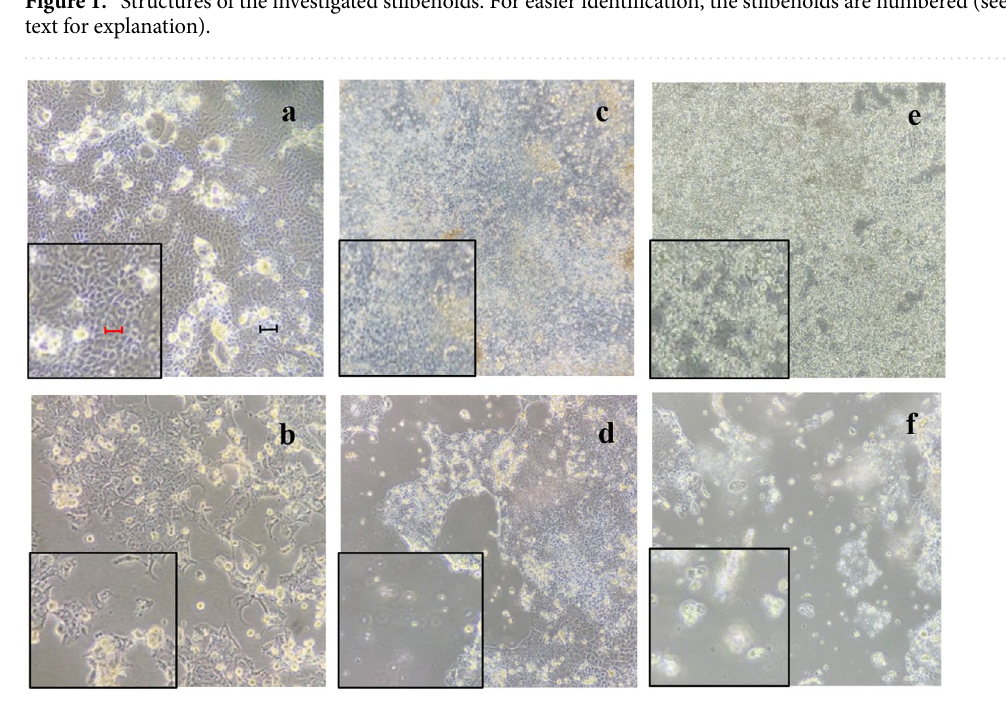
Figure 2. Microscopic observations of differentiated Caco-2 cell morphology after treatment with: ( a ) DMSO vehicle only, the cells are all well adherent to the substrate and appear whit a physiological morphology; ( b ) 5-AzaC positive control, is evident an inhomogeneous cellular mat and contracted cells; ( c ) VF20, some cells appear detached and rounded (evident in the difficulty of focusing); ( d ) VF200, an evident inhomogeneous cellular mat; ( e ) B33, cells still adhering to the substrate appear however rounded; ( f ) B75, most of the cells lose adhesion to the substrate, also evident in the difficulty of focusing. Every picture reports a 5 × magnification on the left for a better image evaluation. Black bar represents 10 µm, the red one, 50